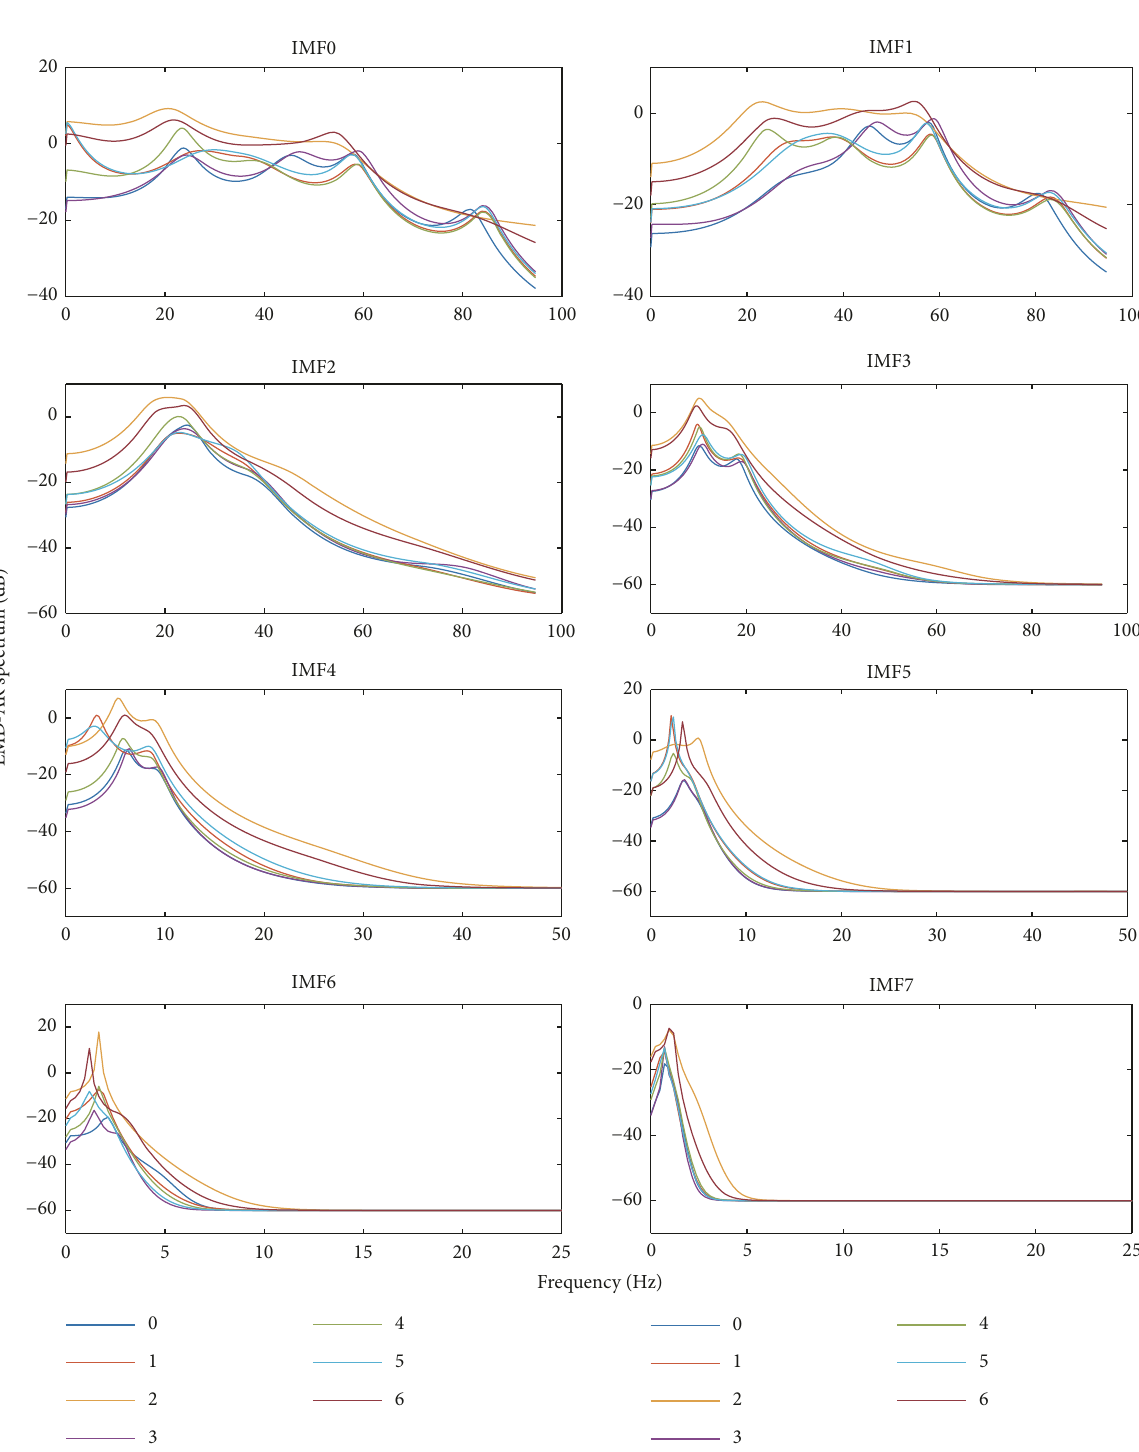
Figure 4: Comparison of EMD-AR spectra of the first 8 IMF components of bogie signals in 7 health conditions: (0) normal condition; (1) failure of the air springs; (2) failure of the antiyaw damper; (3) failure of the lateral damper; (4) failure of the air spring + the antiyaw damper; (5) failure of the air spring + the lateral damper; (6) failure of the lateral damper + the antiyaw